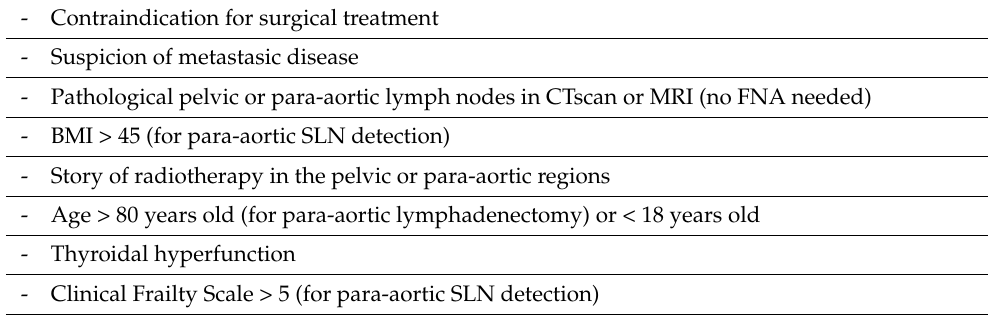
Table 1. Exclusion